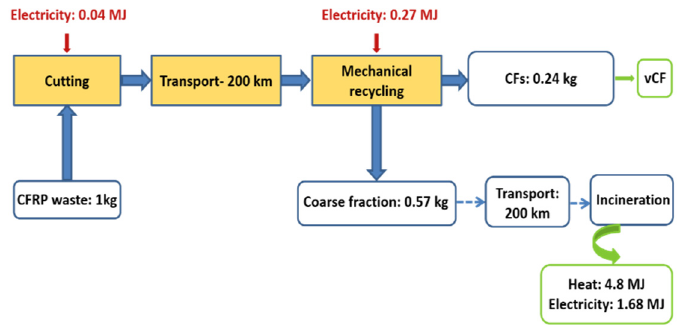
Figure 15. Flow diagram of mechanical recycling with incineration.